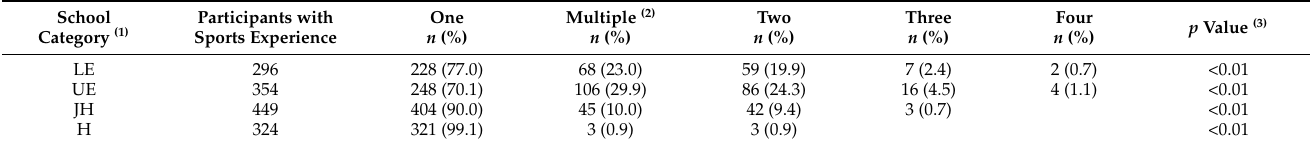
Table 1. The number of sports items for the study participants ( n =